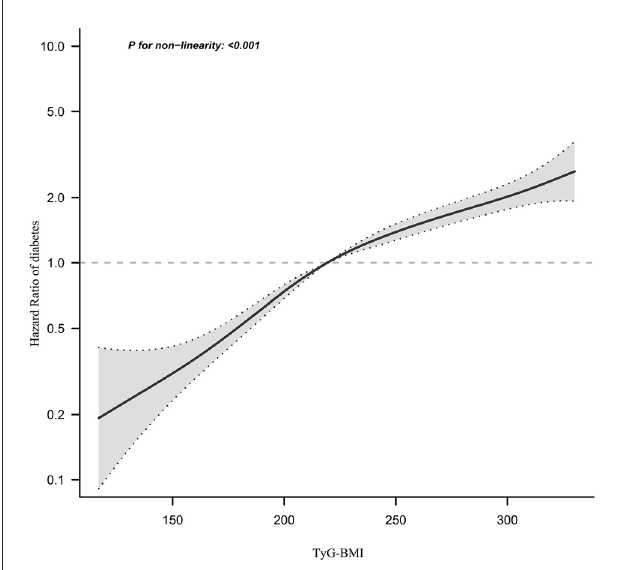
FIGURE6 The non-linear relationship between TyG-BMI and the risk of diabetes in prediabetic patients. We used a Cox proportional hazards regression model with cubic spline functions to evaluate the relationship between the TyG-BMI and diabetes risk. The result showed that the relationship between the TyG-BMI and diabetes risk in prediabetic patients was non-linear, with the inflection point of the TyG-BMI ratio being